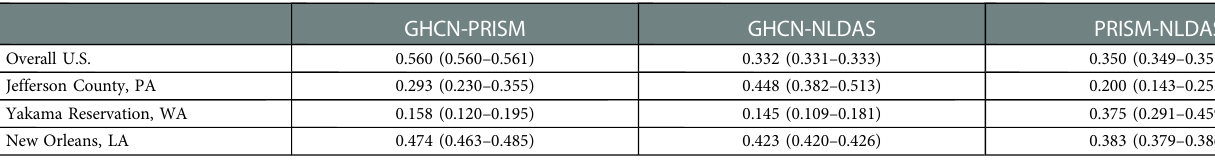
TABLE 6 Local examples of EPE identi fi cation (> 99th percentile), 2011 –